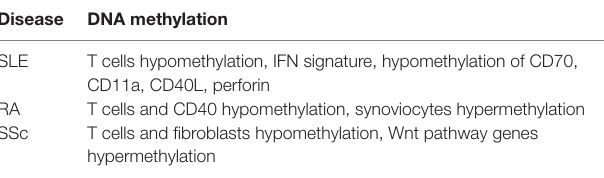
TABLe 4 | DNA methylation process in autoimmune diseases. Disease DNA methylation SLE